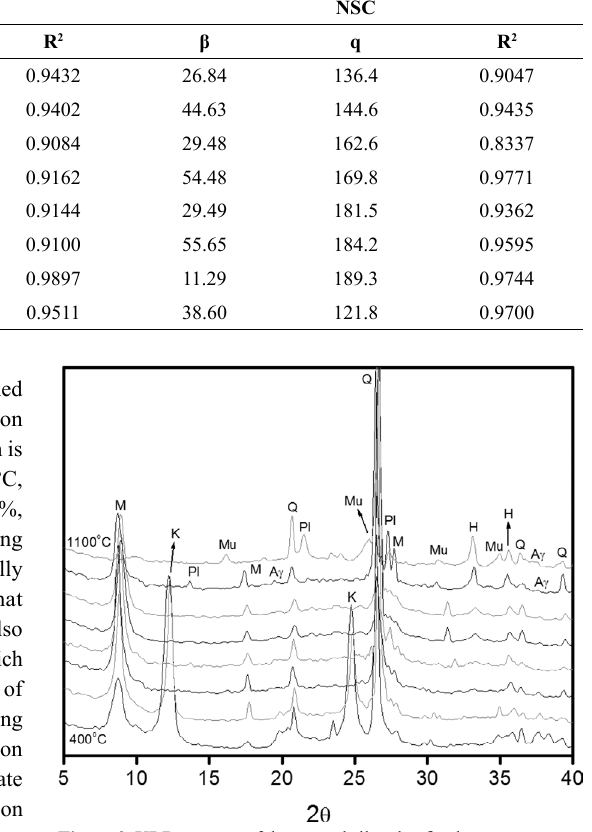
Figure 9. XRD patterns of the natural silty clay fired at temperatures from 400 to 1100°C. A = γ-Alumina; H = Hematite; K = kaolinite; γ M = micaceous mineral; Mu = mullite; Pl = plagioclases; Q = quartz.